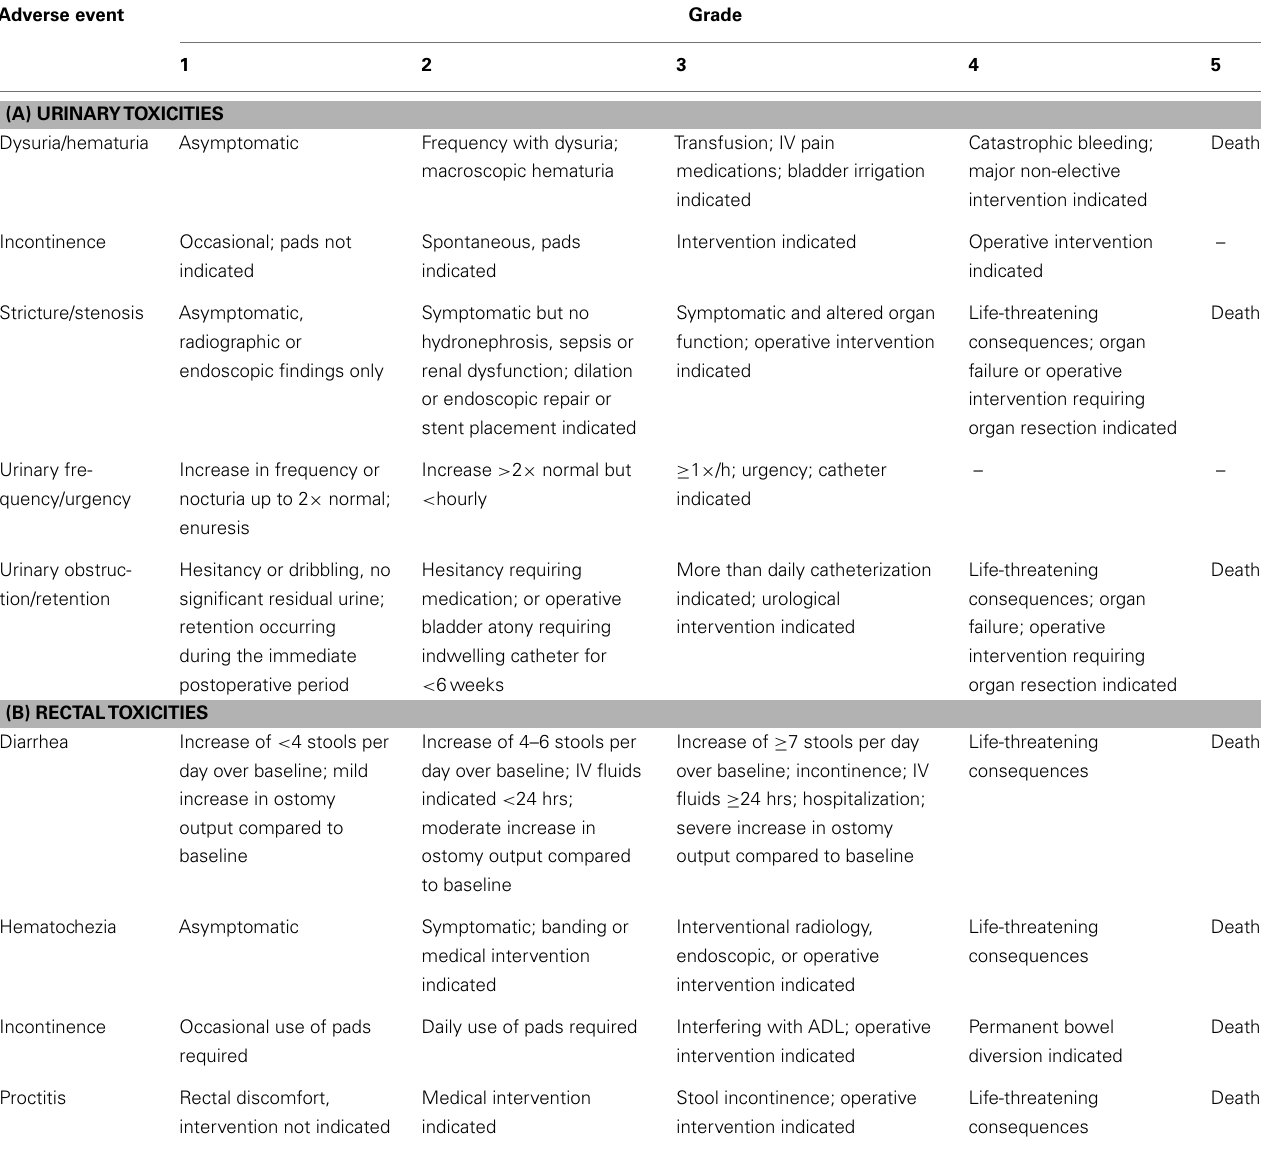
Table 1 | National Cancer Institute common terminology criteria for adverse events, version 3.0 for (A) urinary and (B) rectal toxicities . Adverse